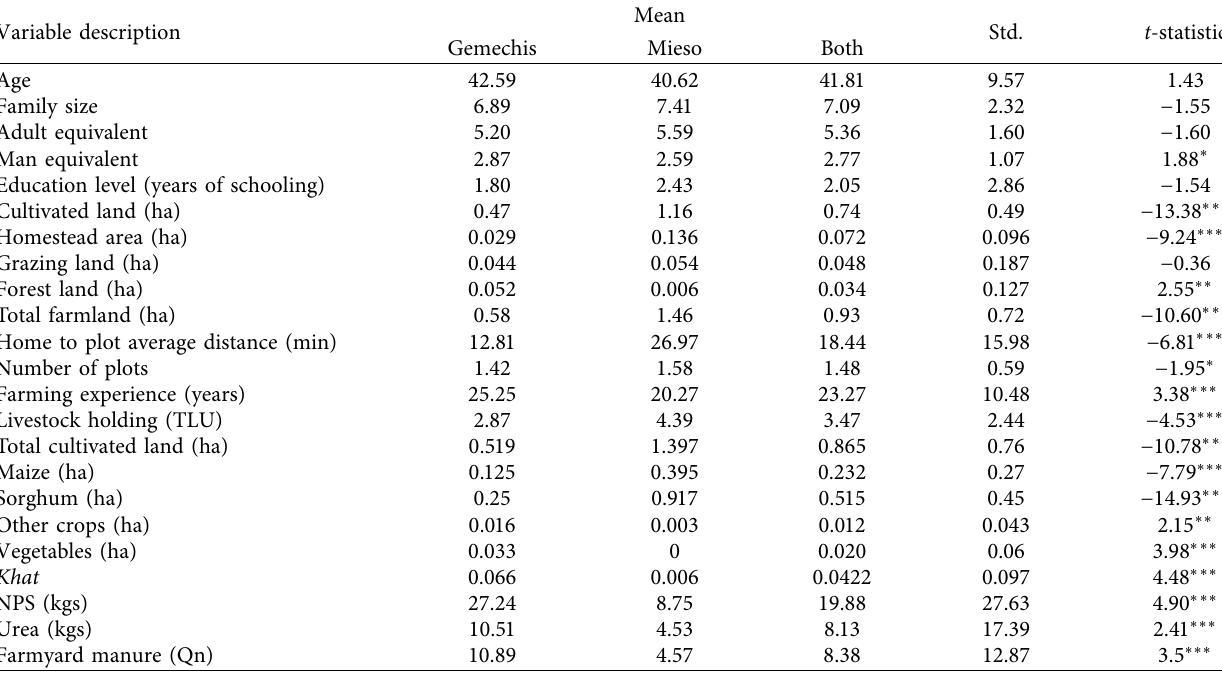
Table 2: Age, family structure, crops grown, and inputs used by HHs during the 2017/18 production year. Variable description